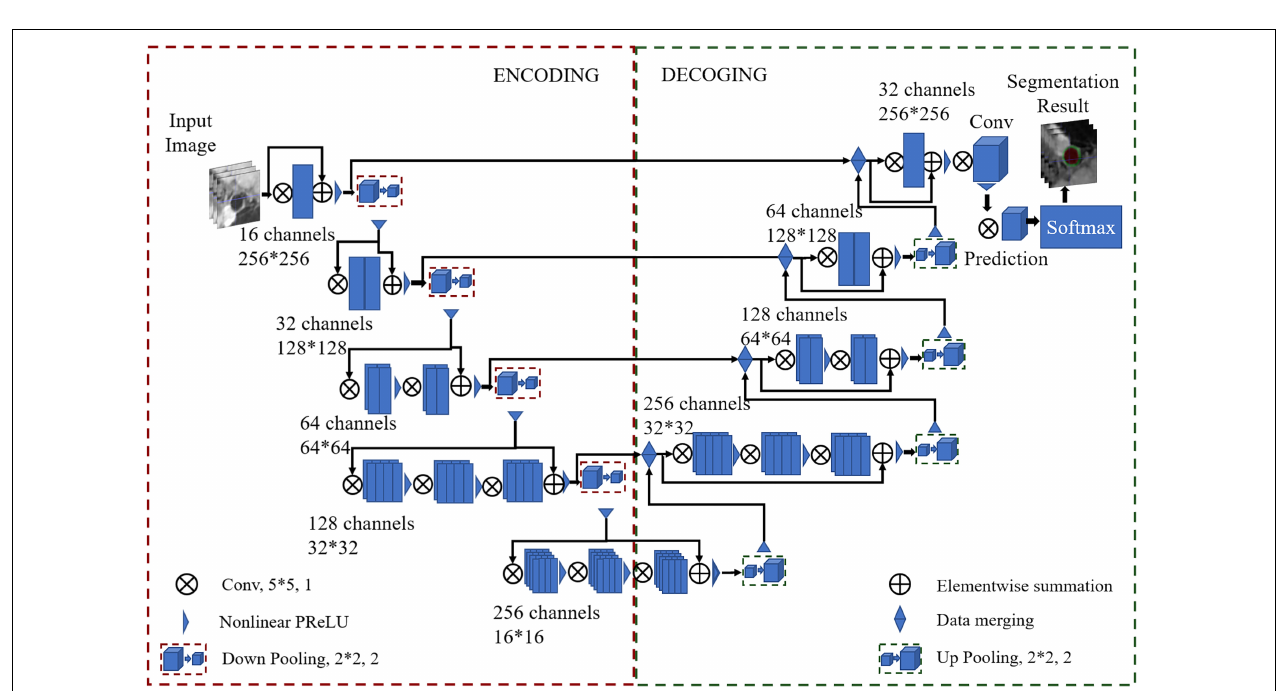
FIGURE 2 | The architecture of the proposed CNN-based